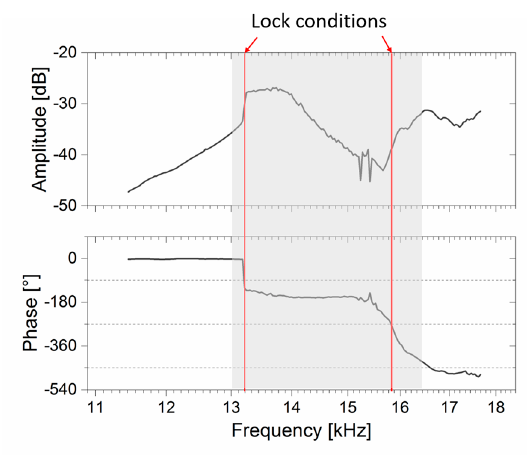
Figure 5. Bode diagram of a cantilever in contact with a silicon